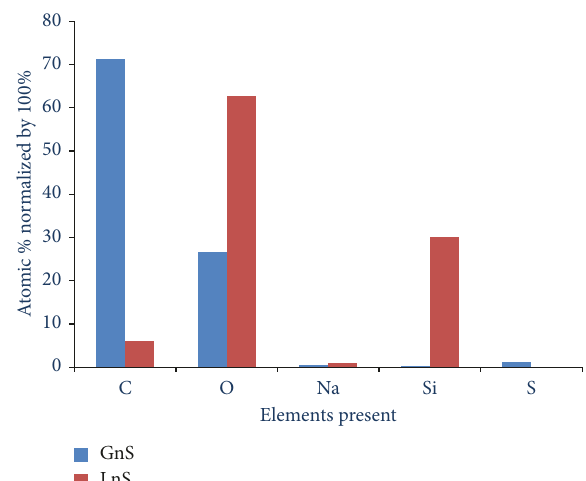
Figure 4: Comparison of the elemental composition of GnS and